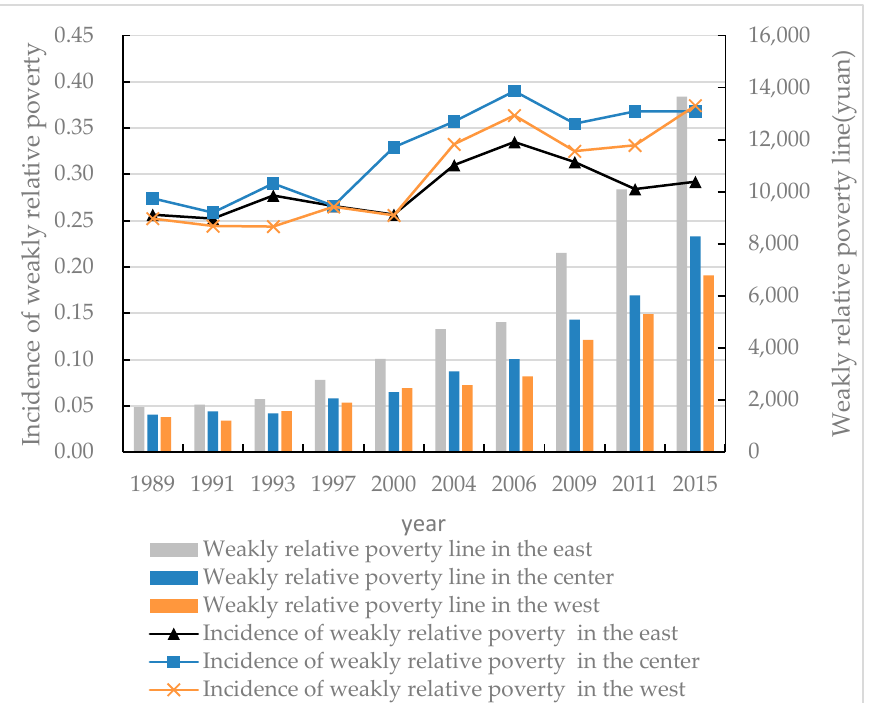
Figure 4. Weakly relative poverty in the eastern, central, and western regions. Note: Strongly relative poverty 1 is strongly relative poverty—50% of median income, strongly relative poverty 2 is strongly relative poverty—50% of average income.